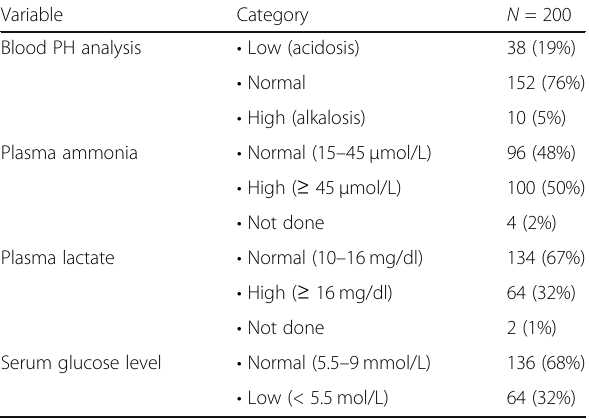
Table 5 Routine screening investigations for diagnosis of